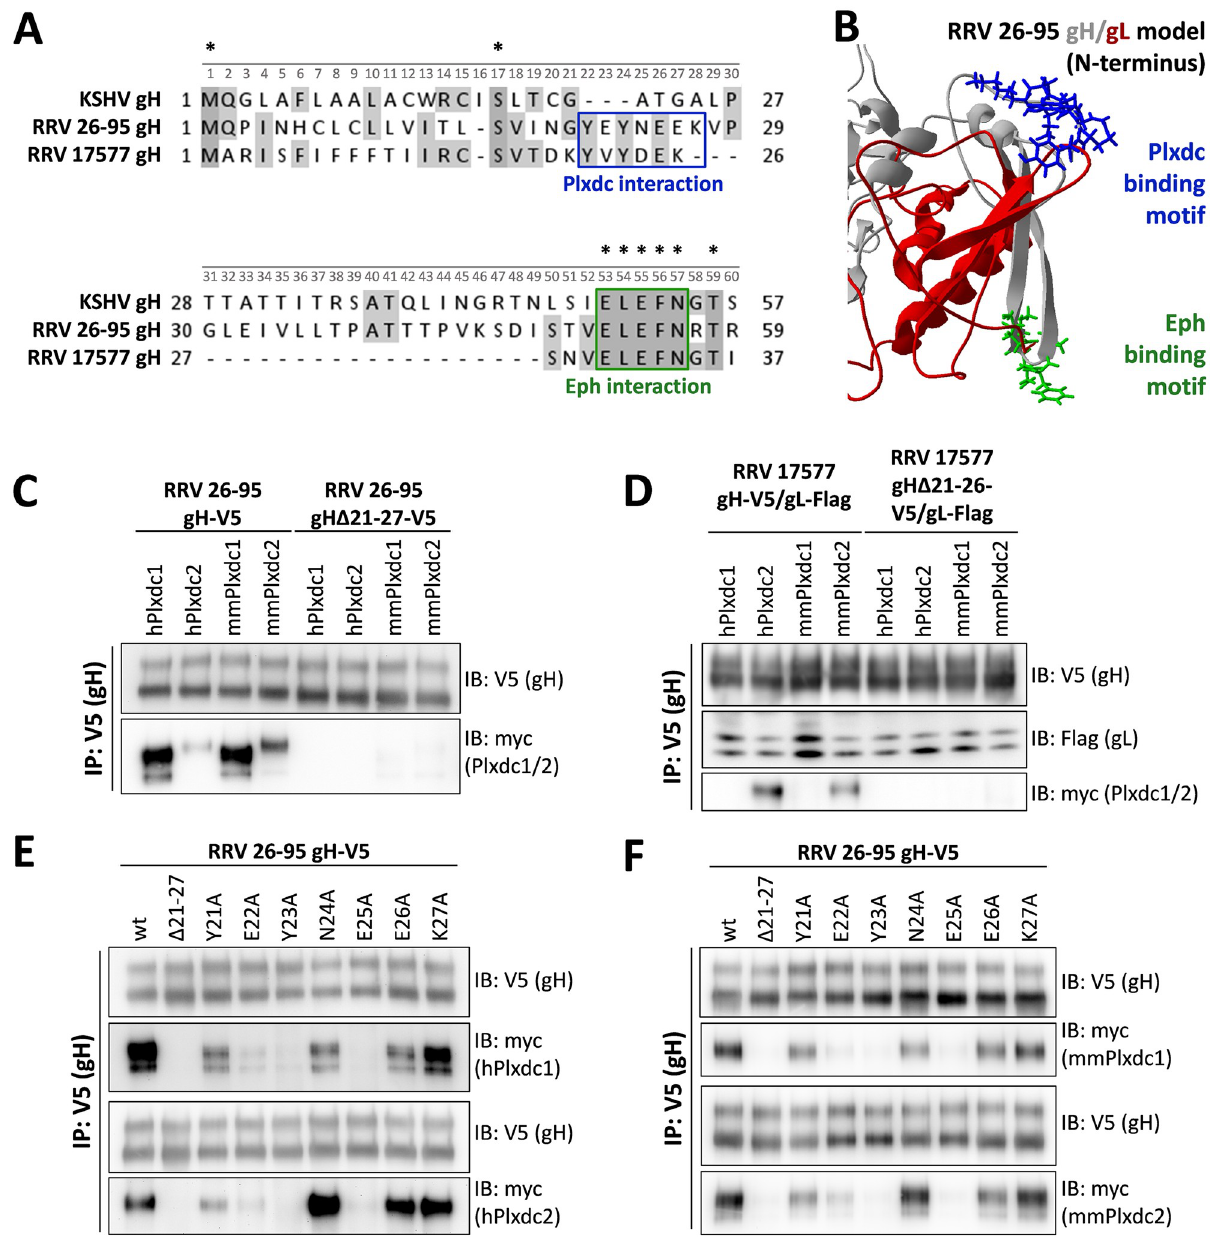
Fig 3. An amino acid sequence motif in the N-terminal region of RRV 26–95 and RRV 17577 gH is essential for the Plxdc interaction. A) Multiple sequence alignment of the N-terminal region of gH of KSHV and the two RRV isolates 26–95 and 17577. Boxes indicate the binding motives for Eph receptors (green) and Plxdc receptors (blue). Numbers above sequences represent positions in the alignment, asterisks indicate conserved amino acids. Individual amino acid positions are given to the left and right of the respective gH sequence. B) Homology-based structure prediction of the RRV 26–95 gH/gL complex based on the crystal structure of the EBV gH/gL complex (PDB number 3PHF) using the Iterative Threading ASSembly Refinement (I-TASSER) server and the CO-THreader (COTH) algorithms for protein-protein complex structure and multi-chain protein threading. The Eph receptor interaction motif is shown in green, the Plxdc interaction motif is shown in blue, gL is shown in red, gH is shown in grey. C) Deletion of the Plxdc interaction motif in RRV 26–95 gH (amino acid 21–27, “YEYNEEK”) abrogates gH interaction with Plxdc1 and Plxdc2. V5-tagged gH wt or gH Δ 21–27 were immunoprecipitated in the presence of full-length human or Macaca mulatta Plxdc1-myc or Plxdc2-myc using monoclonal antibody to the V5-tag. Precipitates were analyzed by Western blot. D) Deletion of the Plxdc interaction motif in RRV 17577 gH (amino acid 21–26, “YVYDEK”) abrogates gH interaction with Plxdc2. V5-tagged gH wt or gH Δ 21–26 was co-expressed with Flag-tagged RRV 17577 gL. gH-V5/gL-Flag complexes were immunoprecipitated in the presence of full-length human or Macaca mulatta Plxdc1-myc or Plxdc2-myc using monoclonal antibody to the V5-tag. Precipitates were analyzed by Western blot. E) Mutational scan of the Plxdc interaction motif (amino acid 21–27, “YEYNEEK”) of RRV 26–95 gH identifies human Plxdc1/2-interacting residues. V5-tagged gH mutants were immunoprecipitated in the presence of full-length human Plxdc1-myc